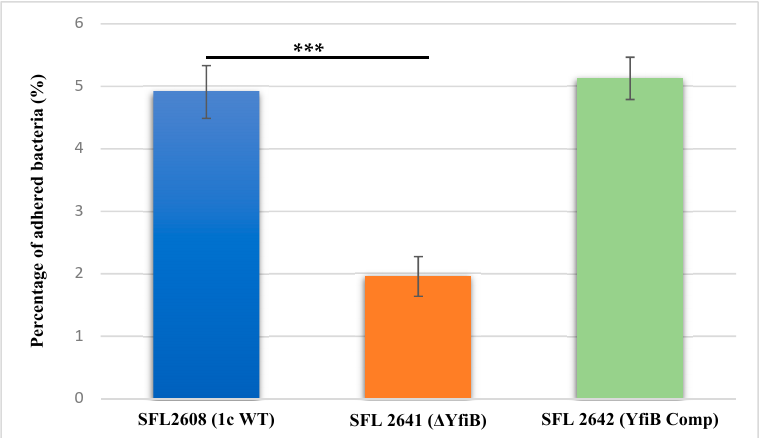
Figure 4. Graphical representation of percentage adhesion to BHK cells by S. flexneri strains. The 1c (SFL2608), yfiB KO mutant SFL2641 ( ∆ YfiB), and yfiB -complemented strain SFL2642 (YfiBComp) were used to infect the BHK cells. After infection, BHK cells were washed and lysed; lysates were serially diluted before plating on an LB agar plate for enumeration and colony-forming unit (CFU) calculation. The percentage of adhered bacteria was calculated by dividing the total CFU of adhered bacteria by the total CFU of the inoculum. The Y-axis represents the percentage of adhered bacteria to BHK cells after 2 h post infection at 37 ◦ C/5% CO 2 . The results were obtained from six autonomous experiments, and to analyze the statistical differences in the adhesion, a Student’s t -test was performed. Three asterisks represent that the variance observed were statistically significant ( p < 0.001) and standard deviation of the data from the six autonomous experiments is depicted by the error